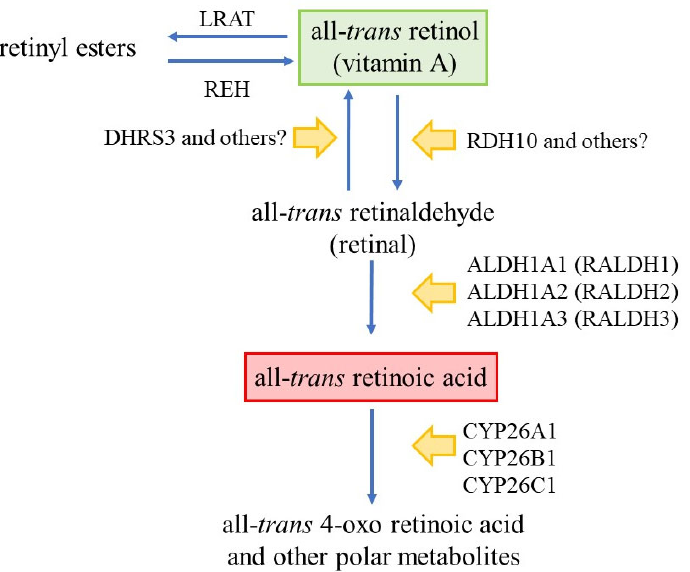
Figure 1. The metabolism of all ‐ trans ‐ retinol into ATRA. All ‐ trans ‐ retinol is mainly taken up into cells via the retinol ‐ binding protein 4 (RB4) blood transport protein binding to the specific cell surface receptor Stra6. LRAT, lecithin retinol acyltransferase; REH, retinyl ester hydrolase; DHRS3, retinaldehyde reductase 3; RDH10, retinol dehydrogenase 10; ALDH, aldehyde dehydrogenases; CYP, cytochrome P450.